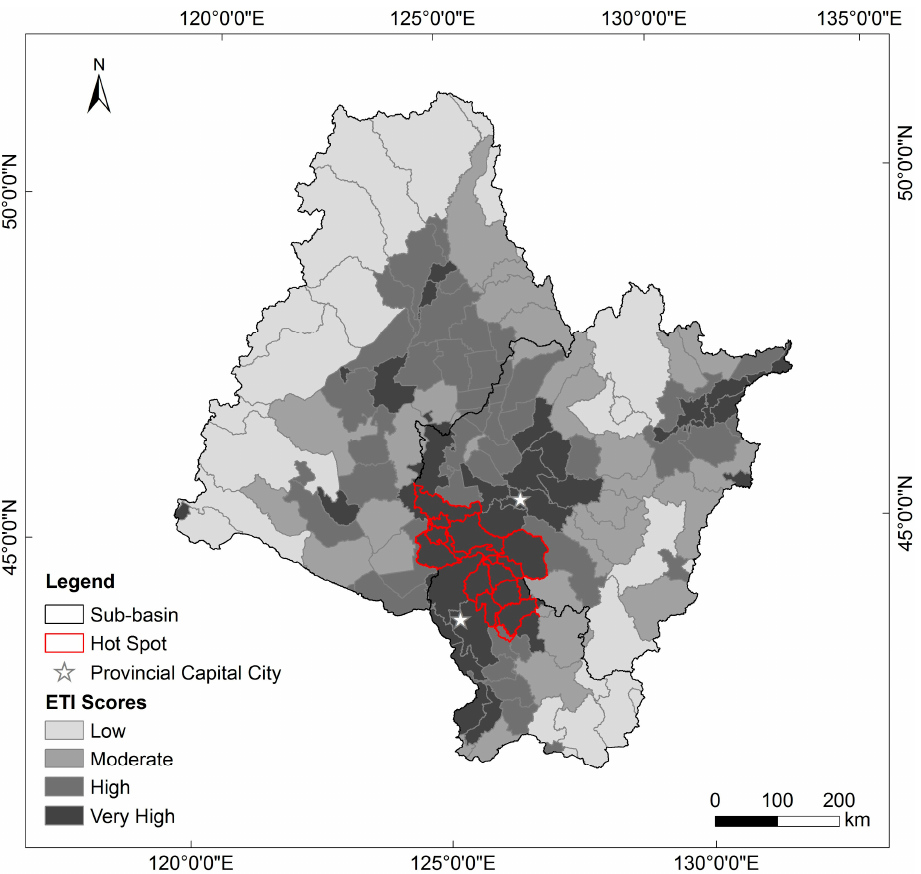
Figure 3. Spatial distribution of the ecological threat index (ETI) in the SRB, with low, moderate, high, and very high values sorted by quartile in ascending order with the hot spot locations.